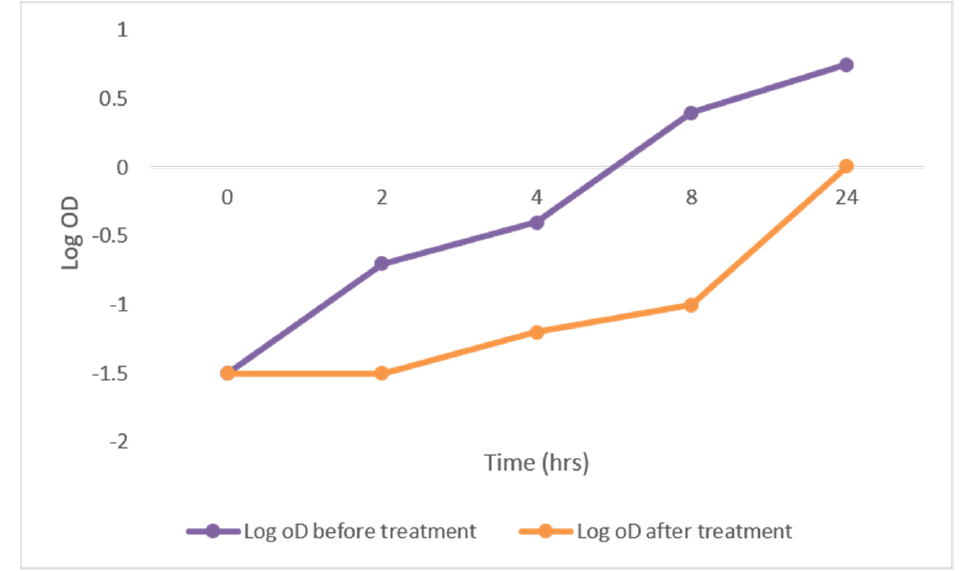
Figure 2. The growth curve of representative MRSA isolates showing a significant reduction in growth after treatment with DEEL.